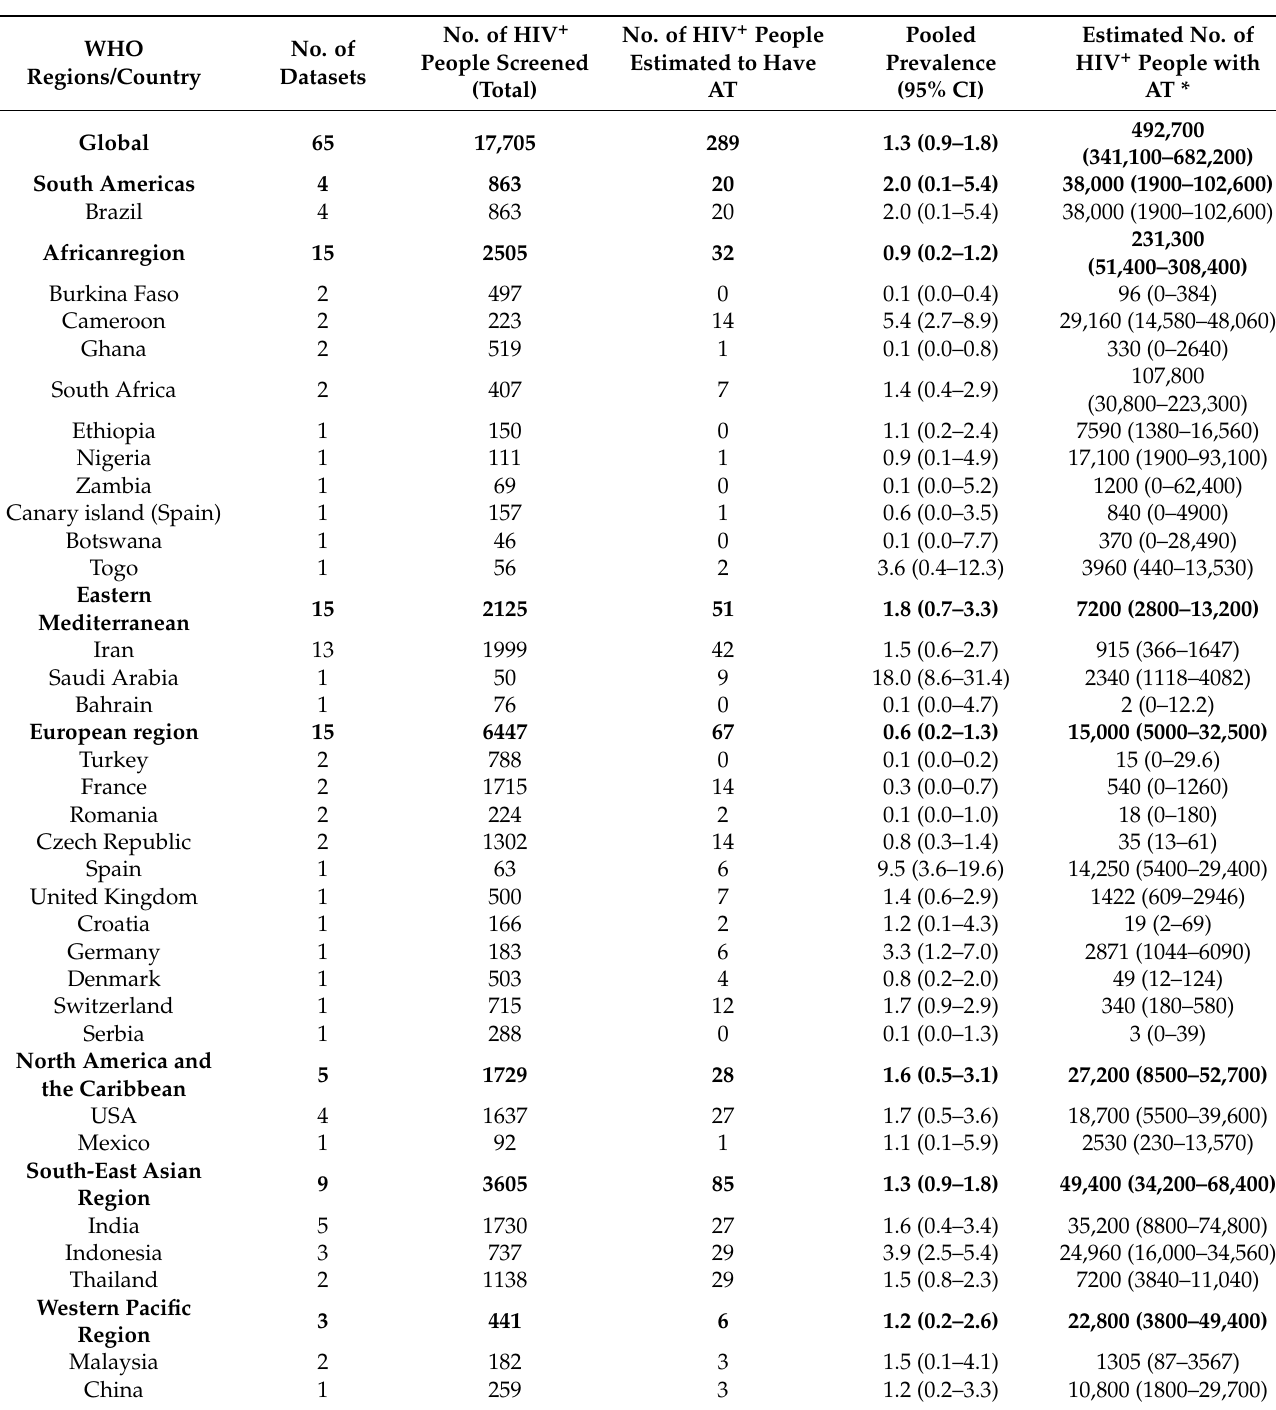
Table 4. Global, regional and national pooled seroprevalence rates for acute Toxoplasma gondii infection (AT) in HIV + people (results from 65 studies performed in 31